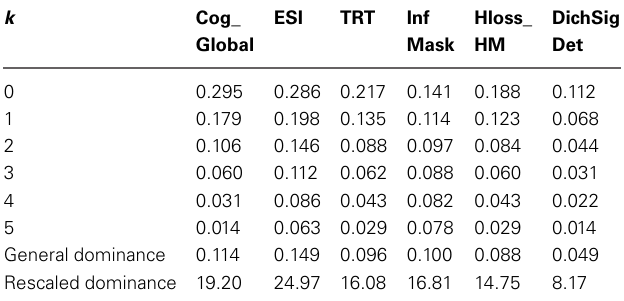
Table 7 | Dominance analysis for prediction of SpeechUnd_Global.